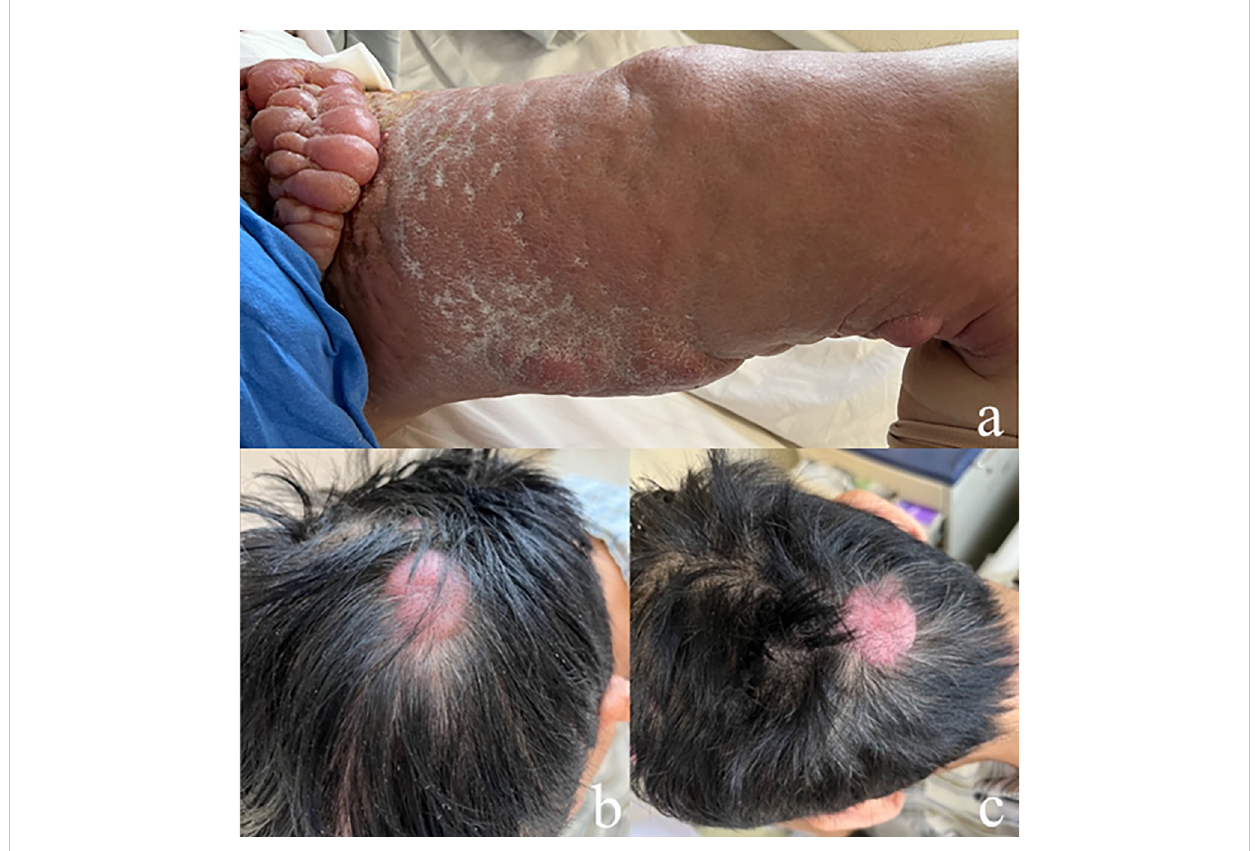
FIGURE 2 Cutaneous metastatic carcinomas. (A) Beaded mass in left groin area and erythematous scleroderma of the left thigh; (B, C) Two fl eshy masses on the